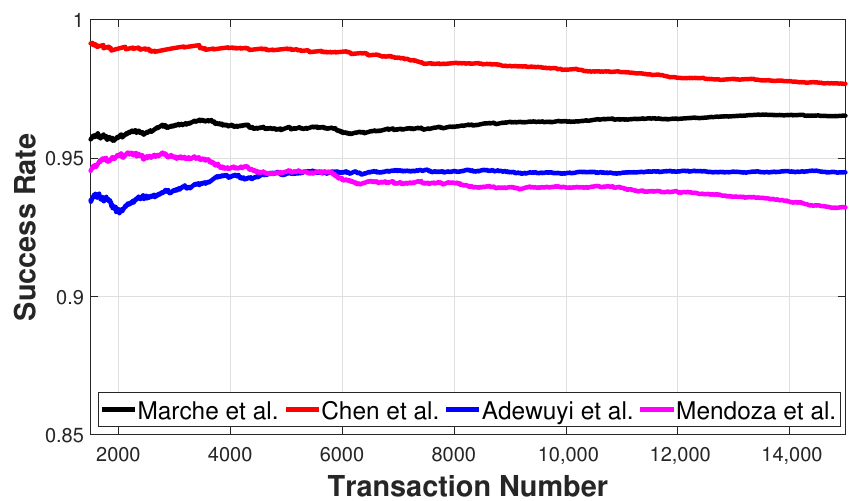
Figure 5. Transaction success rate for different trust management